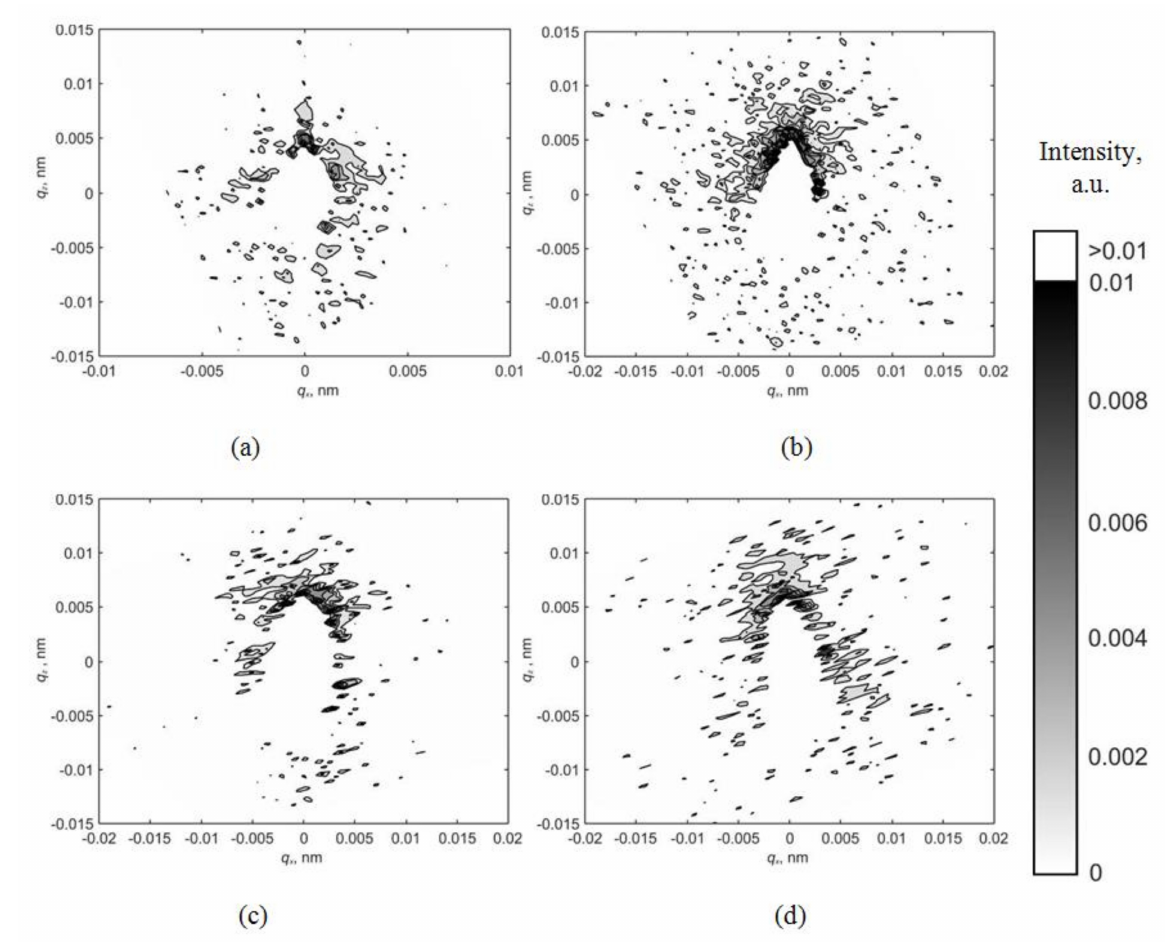
Figure 3. Maps of the asymmetric part of diffuse scattering for reflections ( a ) (110); ( b ) (220); ( c ) (330); ( d ) (440) at a voltage of − 2000